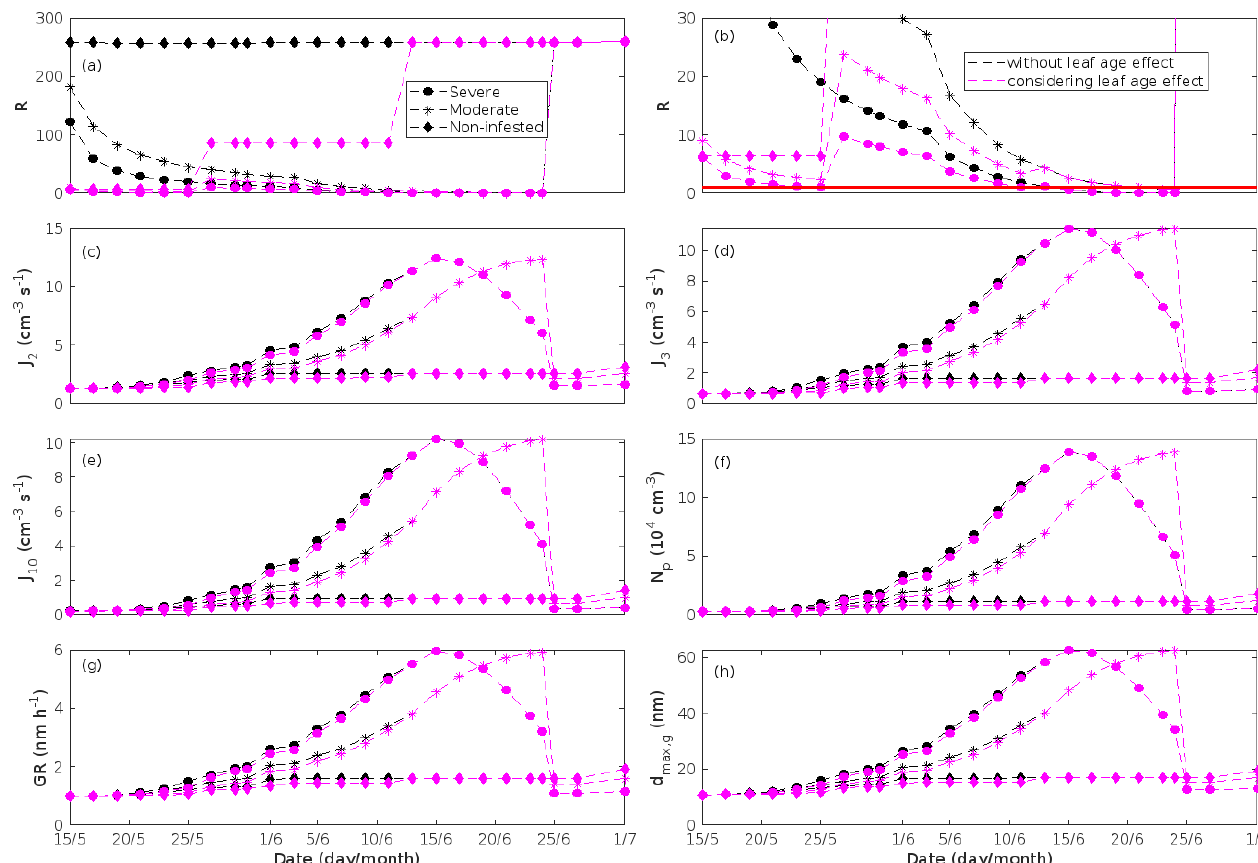
Figure B2. An oak stand infested with European gypsy moth larvae in comparison to a non-infested oak stand simulated with and without considering the impact of leaf age on the rates of emissions. (a) The ratios of isoprene-to-monoterpene carbon concentrations are provided as a zoom in (b) , where the red line indicates R = 1. Formation rates of (c) 2, (d) 3, and (e) 10nm particles. (f) Number concentrations of formed particles, (g) growth rates of newly formed particles, and (h) the daily maxima diameter of the growing particle mode. Symbols are used in the same way as in Fig.